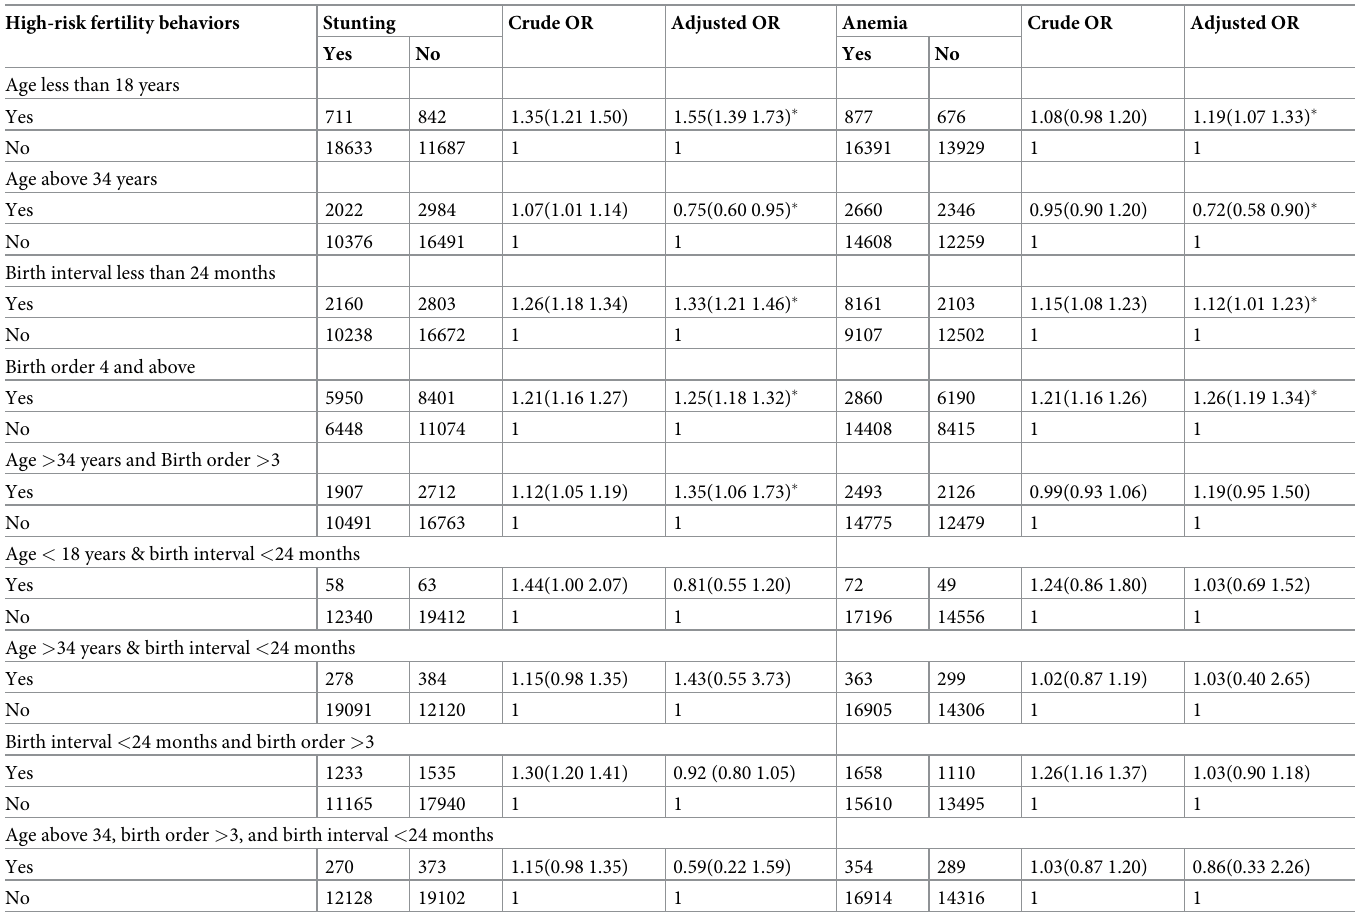
Table 5. Effect of high-risk fertility behavior on child chronic malnutrition and Anemia. High-risk fertility behaviors Stunting Crude OR Adjusted